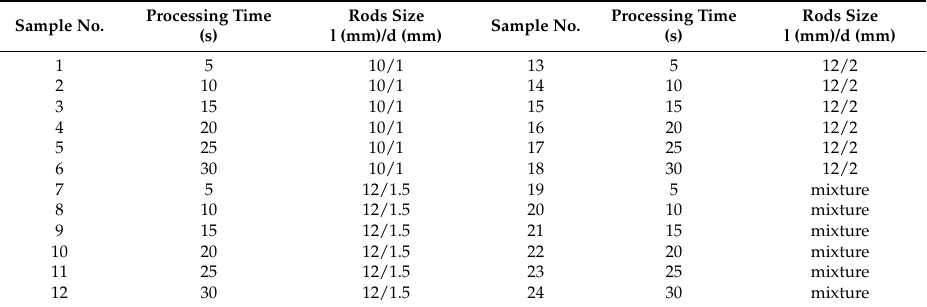
Table 1. Experiments’ parameters for copper ore dry grinding in EMM, material mass 500 g (4% of WCV) and grinding media mass 1500 g (9% of WCV). Sample No.